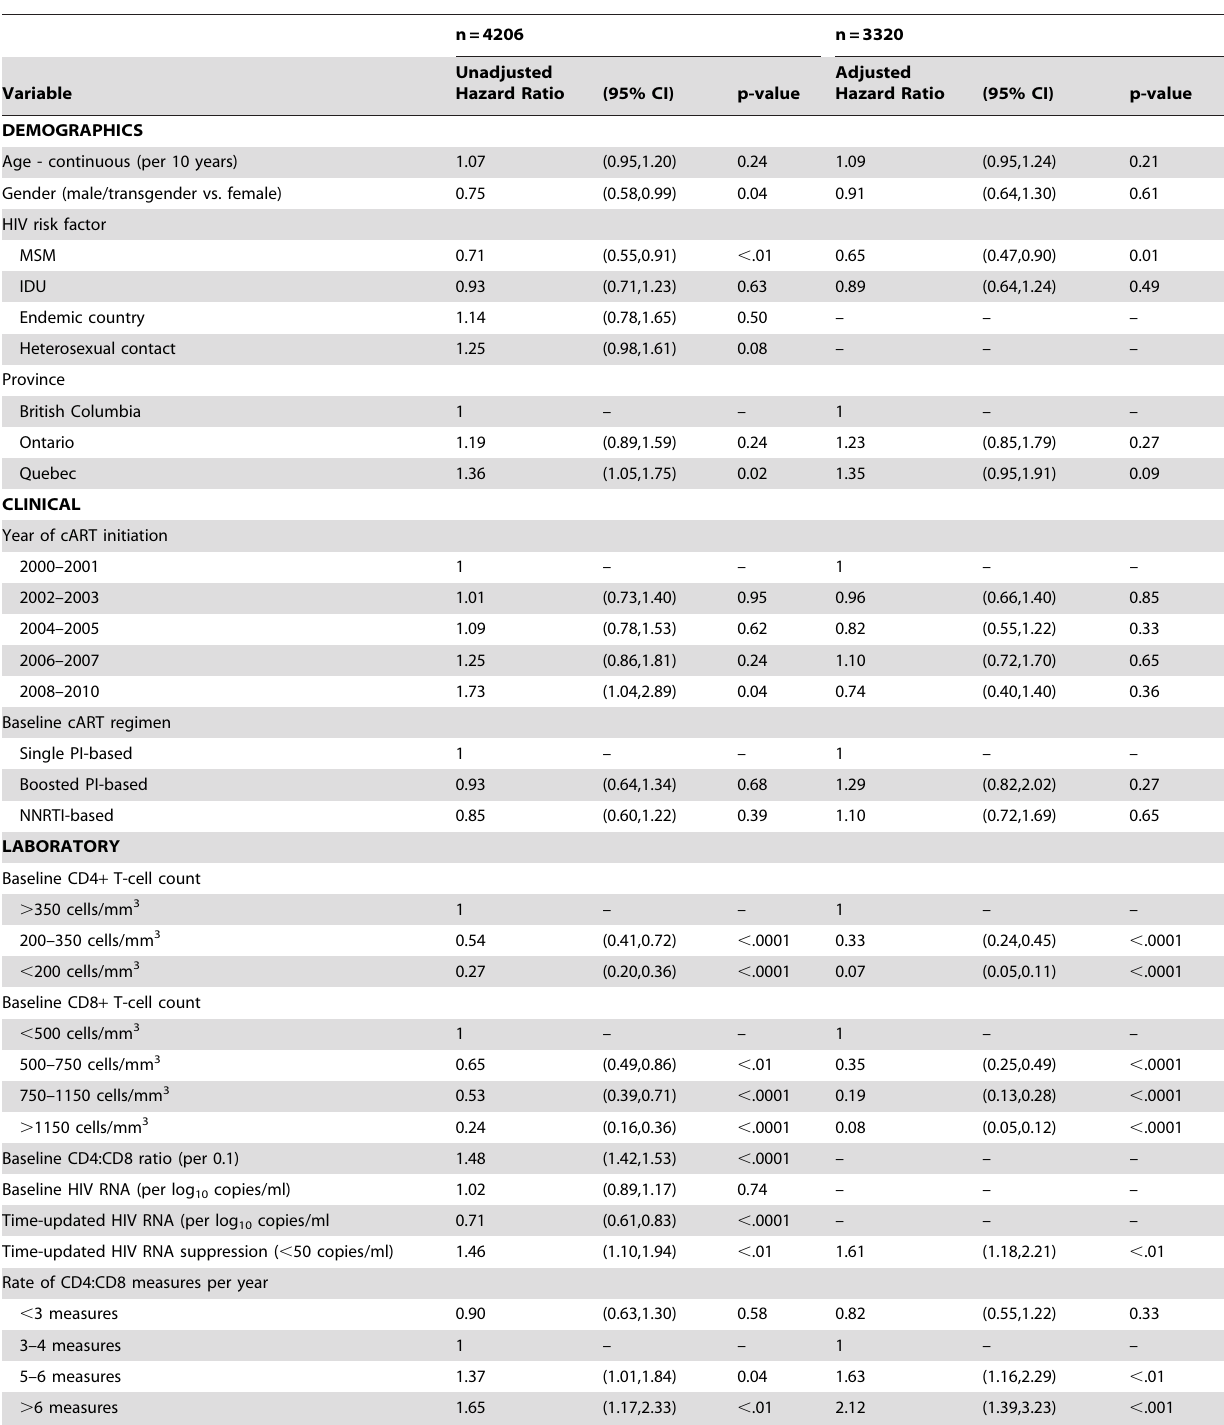
Table 2. Univariable and multivariable proportional hazards model for time to normalization of CD4:CD8 ratio.